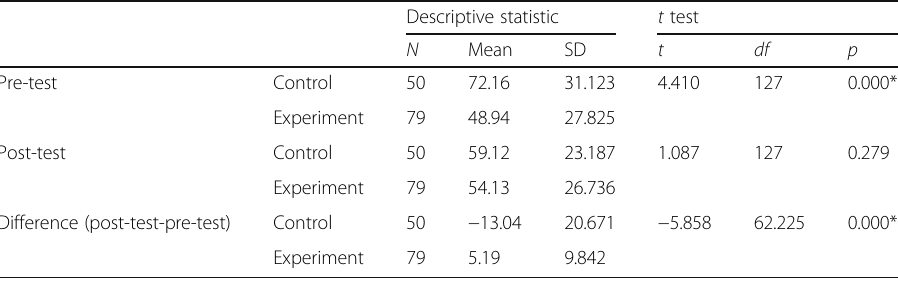
Table 15 Independent t test result for students ’ academic achievements in different groups Descriptive